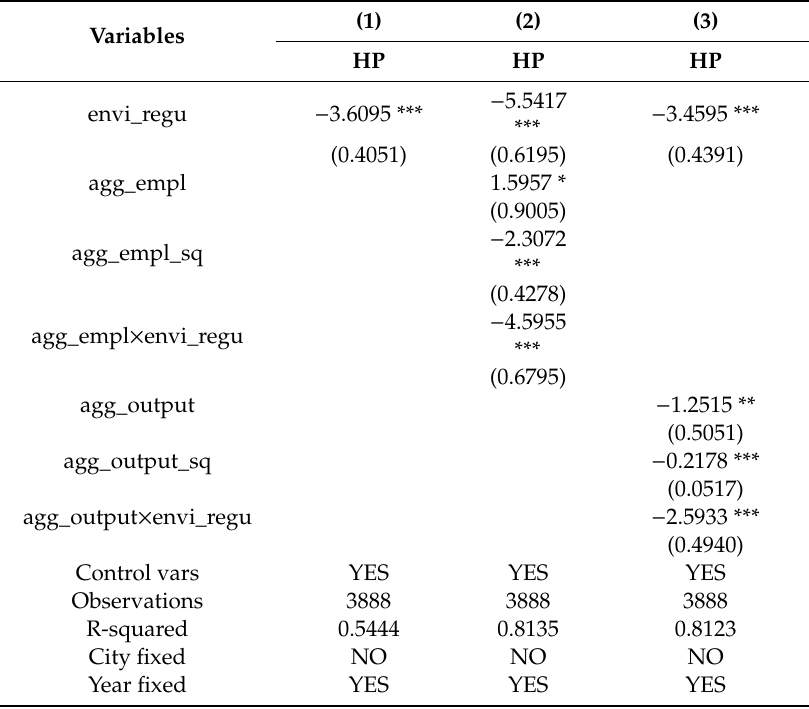
Table 6. Moderating e ff ect—environmental